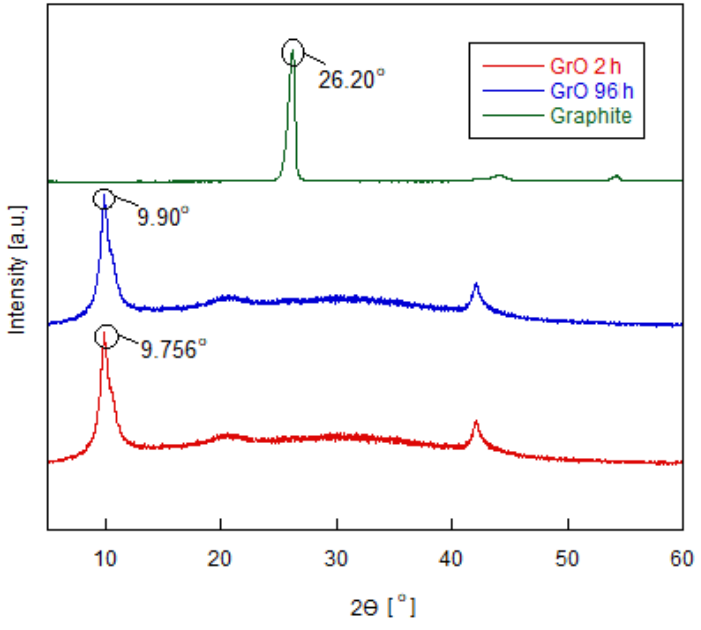
Figure 2. XRD patterns for Graphite, GrO 2 h and GrO 96 h.